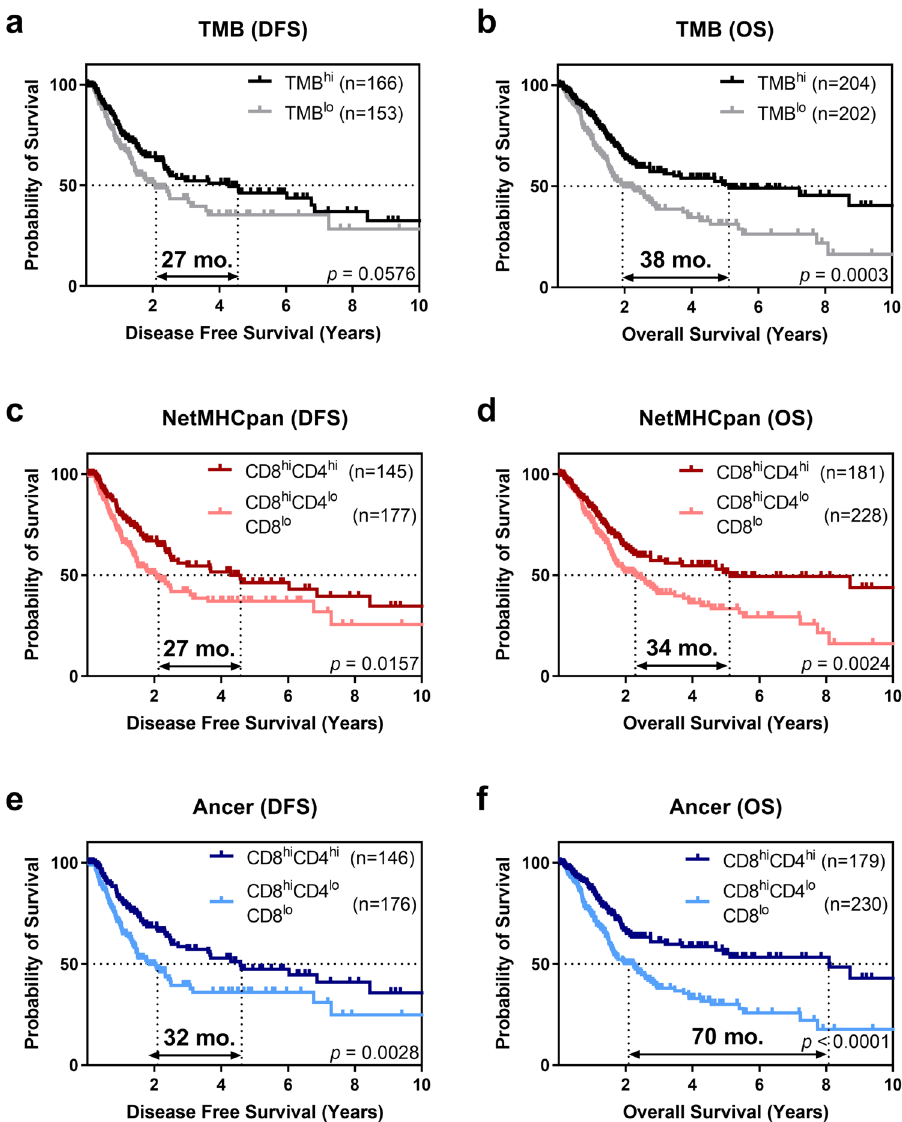
Figure 3. Stratification of cancer patients according to TMB analysis, NetMHCpan analysis, and the Ancer pipeline. TCGA bladder cancer patients were separated based on their median TMB ( a , b ), NetMHCpan neoepitope burden ( c , d ), or Ancer pipeline-defined neoepitope burden ( e , f ). Median disease-free survival (DFS) ( a , c , e ) and median overall survival (OS) ( b , d , f ) were evaluated with the Kaplan–Meier estimator. Double-ended arrows define the differences in median survival times between the groups for each of the analyses. Statistical significance was evaluated using the log-rank test. The largest differential in median overall survival, 70 months, was obtained with the Ancer pipeline and was more than double the difference in median overall survival observed when stratifying patients using NetMHCpan (34